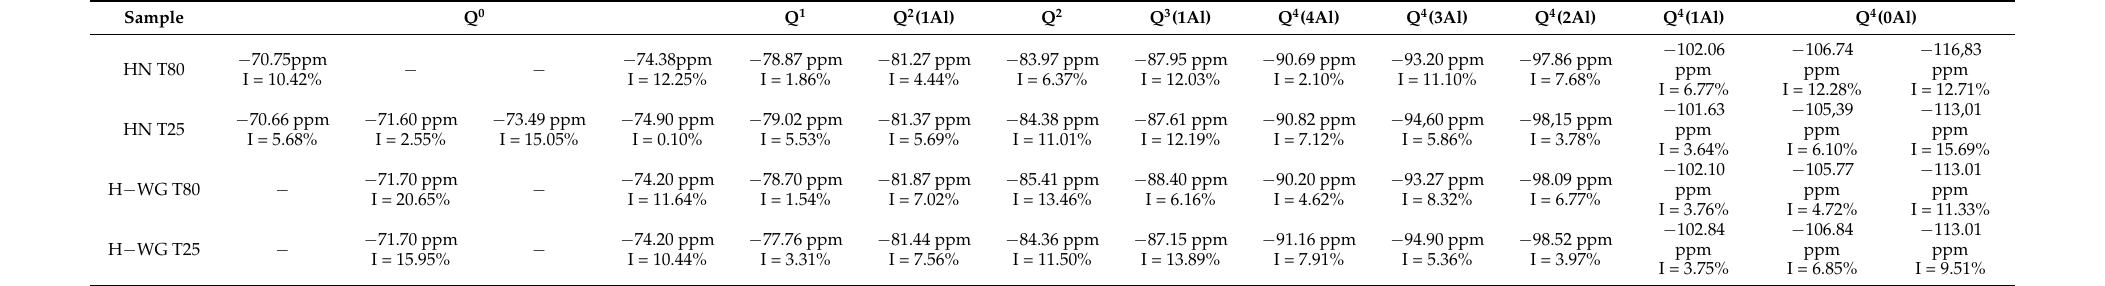
Table 7. Signal positions and intensities on deconvoluted 29 Si MAS-NMR spectra for 2 days hybrid cement pastes.